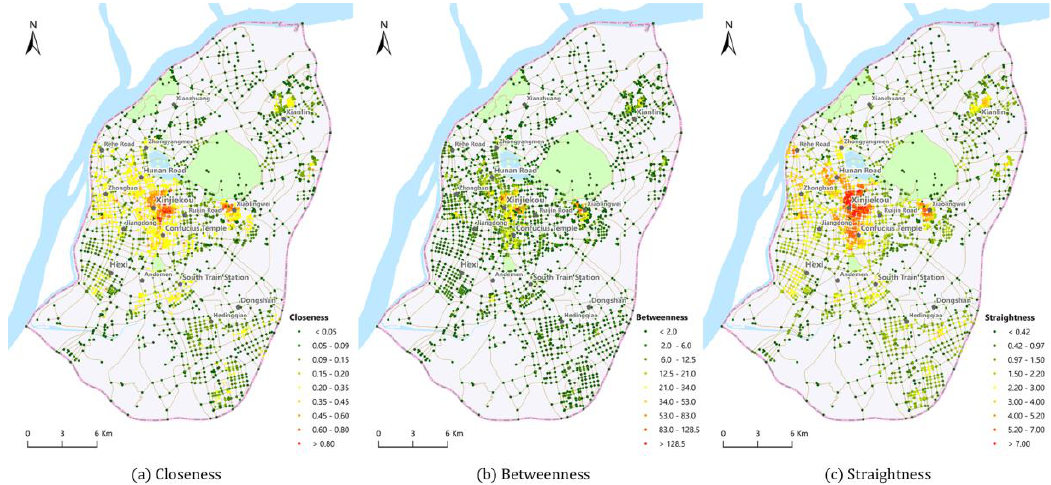
Figure 9. Centrality of road network: ( a ) Closeness; ( b ) Betweenness; ( c ) Straightness.